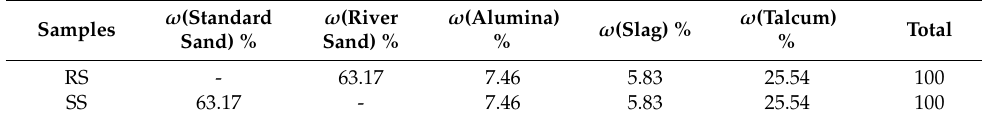
Table 2. Formulation of the samples.